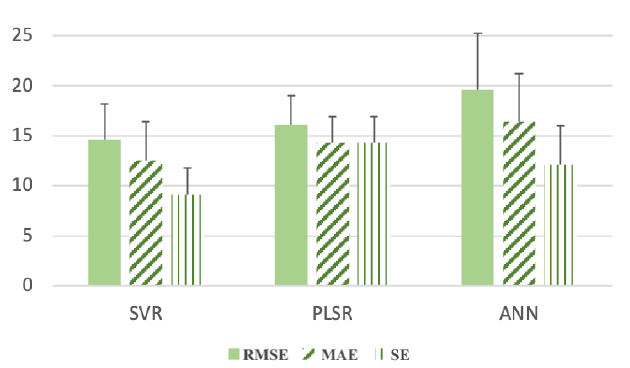
Figure 5. The mean value and standard deviation of RMSE, MAE and SE obtained by SVR, PLSR and ANN using 20 repeated 6-fold